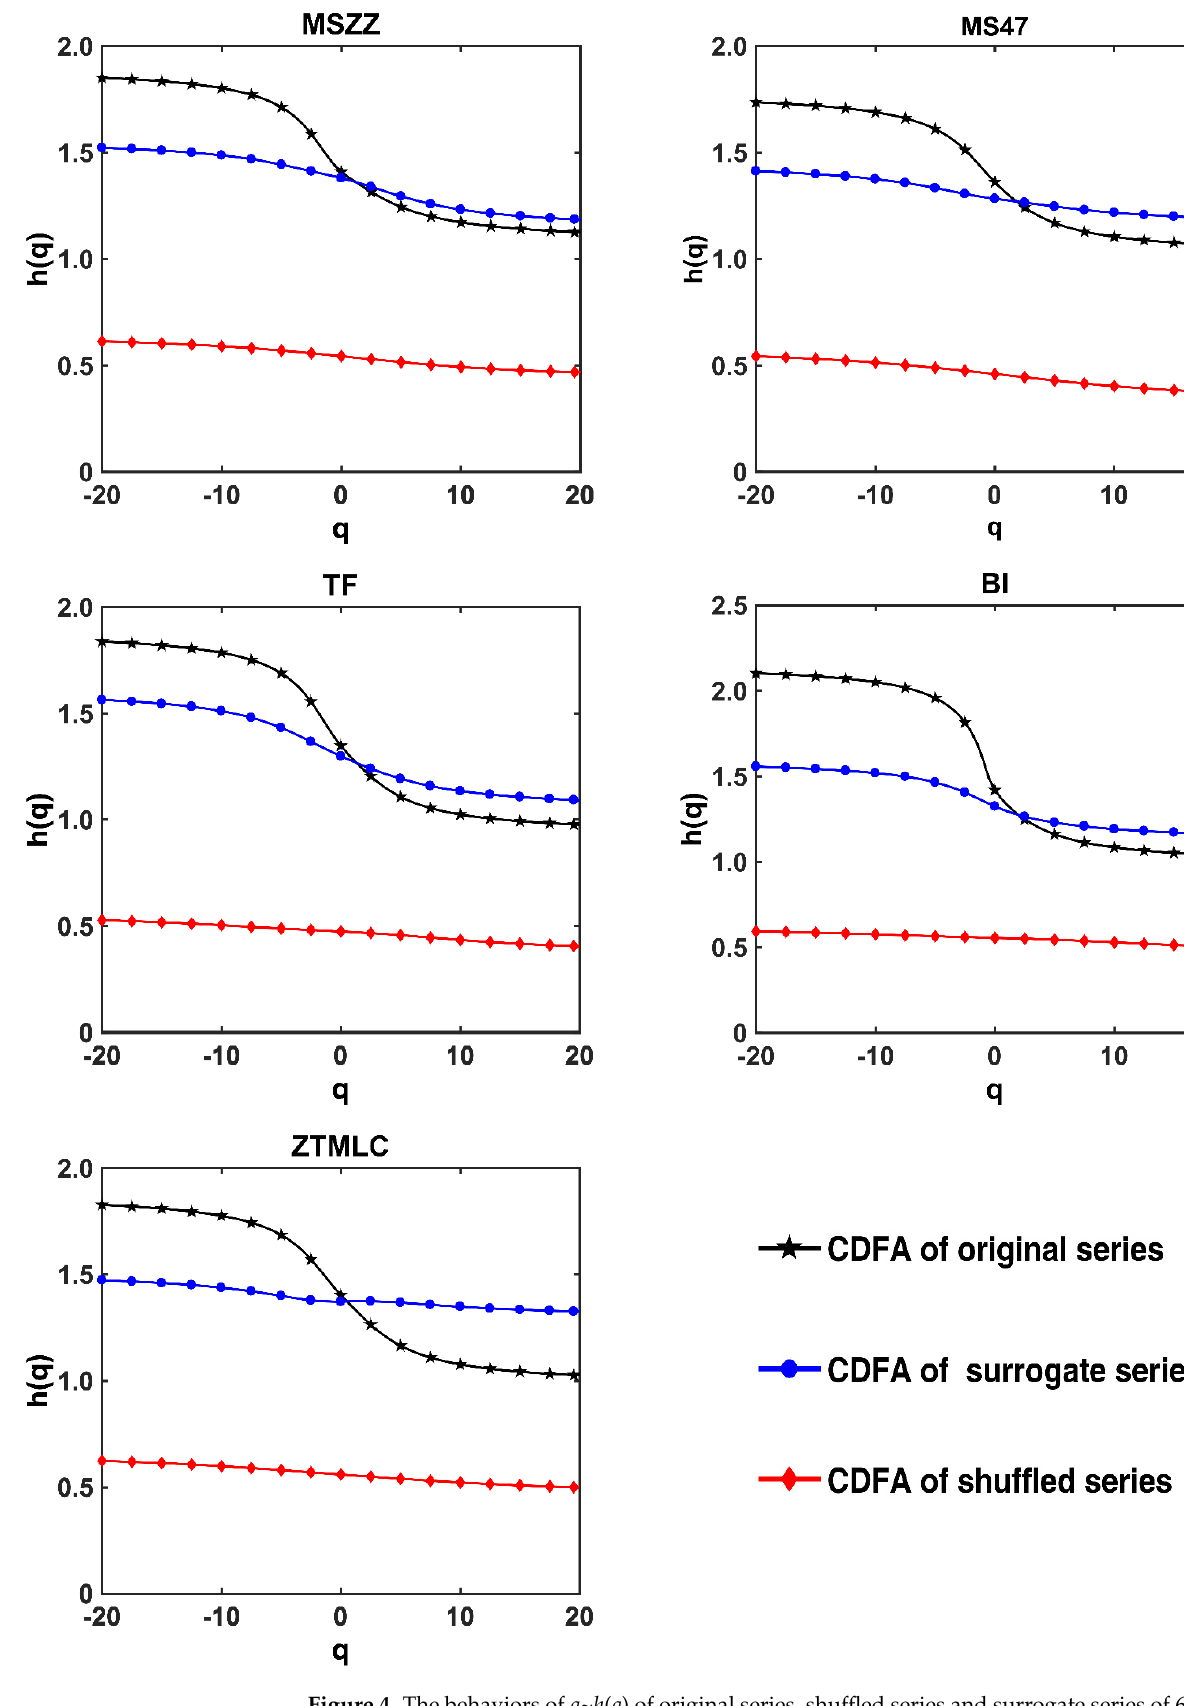
Figure 4. The behaviors of q ~ h ( q ) of original series, shuffled series and surrogate series of 6 pollutants at 9 monitoring stations in Zhengzhou using CDFA